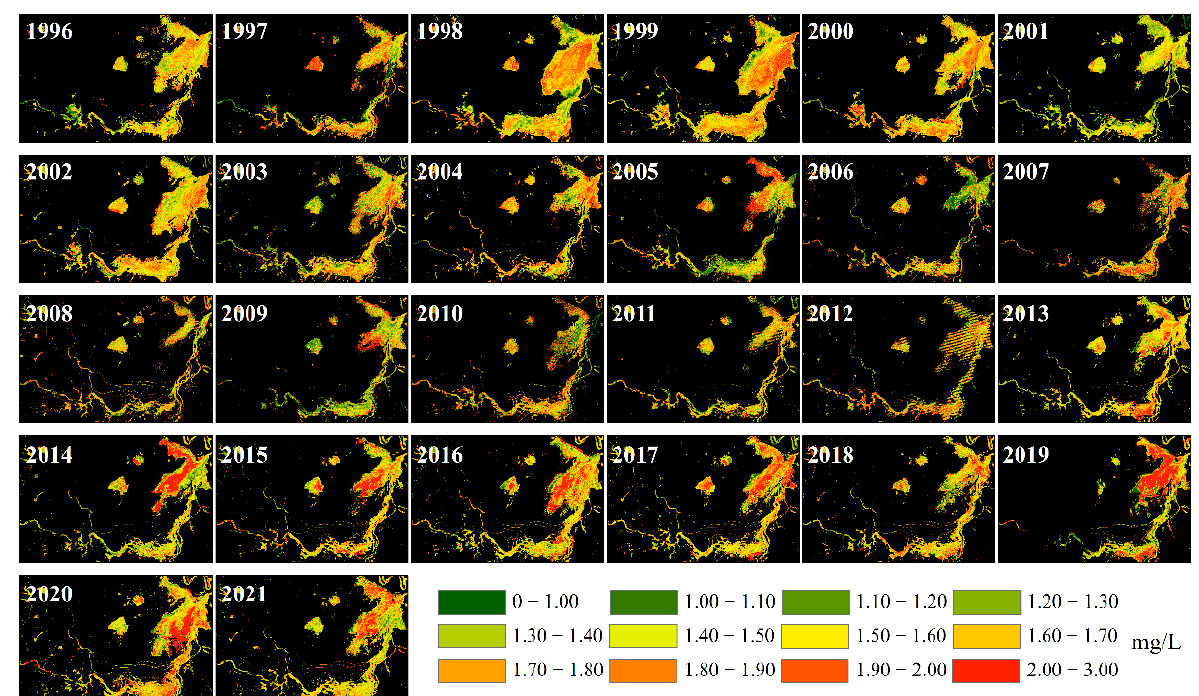
Figure 6. Spatial distribution of TN in Dongting Lake.